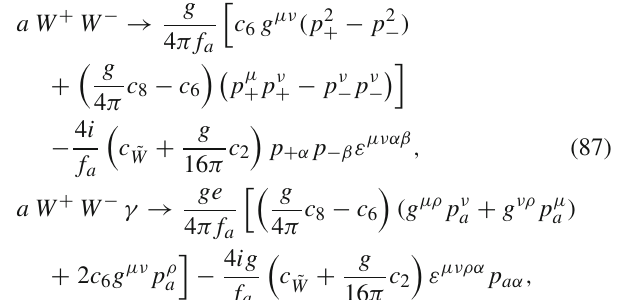
on five distinct operators: { A 1 , A 2 , A 6 , A 8 } and the combi- , A } orthogonal to the a γ γ coupling. nation of { A ˜ ˜ B W